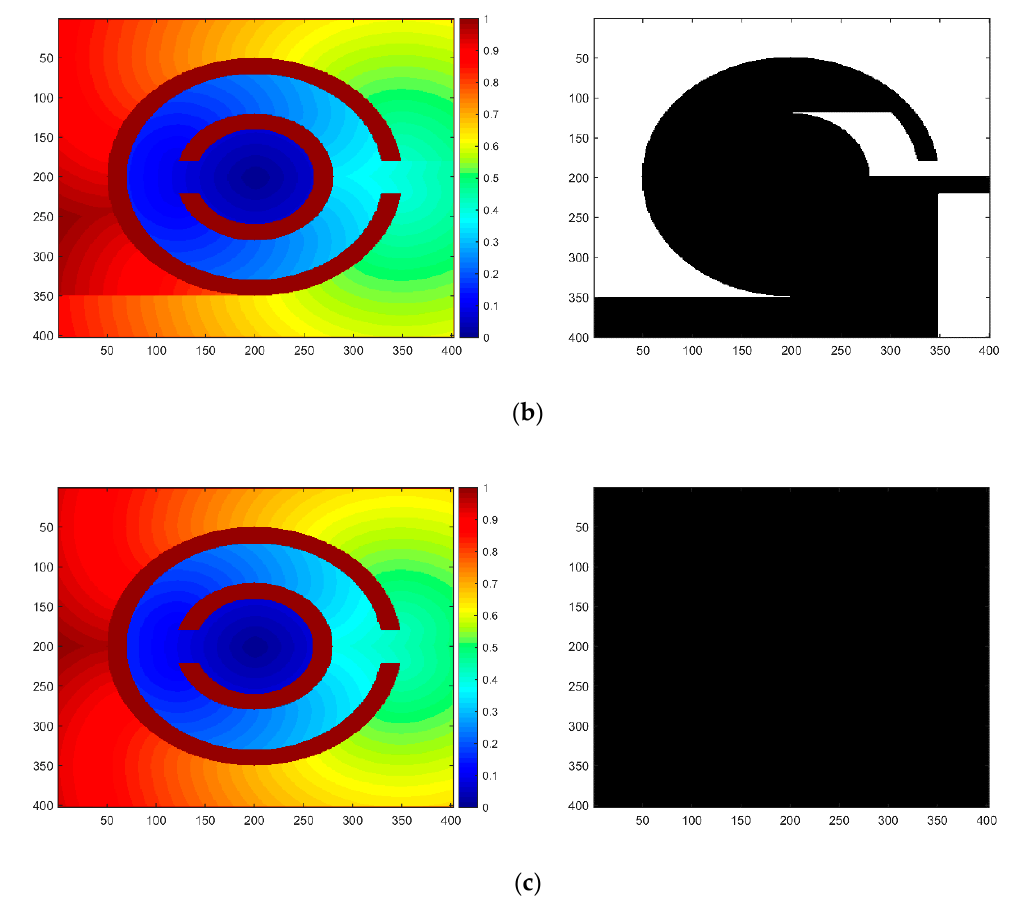
Figure 5. The potential field constructed by the LSM: ( a ) first iteration; ( b ) second iteration; ( c ) third iteration. (The figure on the left shows the calculation results after each iteration, and the figure on the right shows the locked state of the nodes in the model space. The white in the figure represents unlocked and the black represents locked).